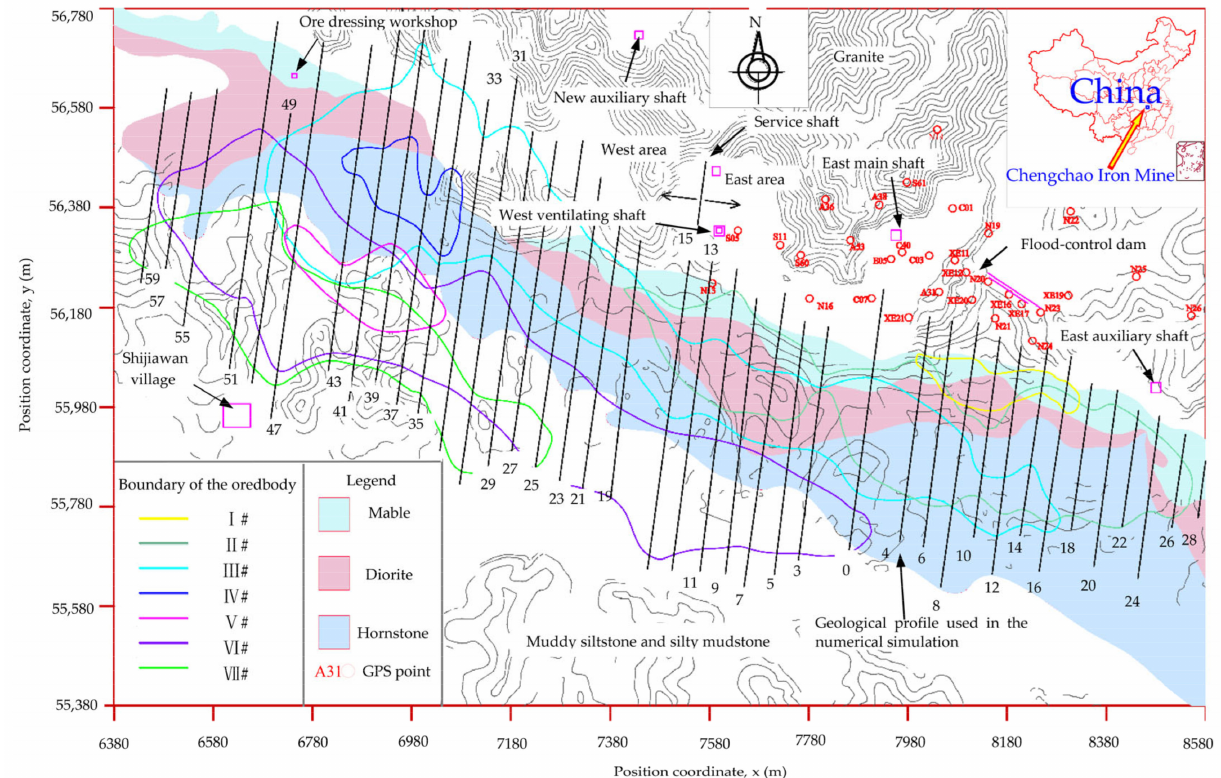
Figure 1. Distribution of the rock masses and orebodies in the Chengchao Iron Mine region [5] (numbers near the exploratory lines are the names of the geological